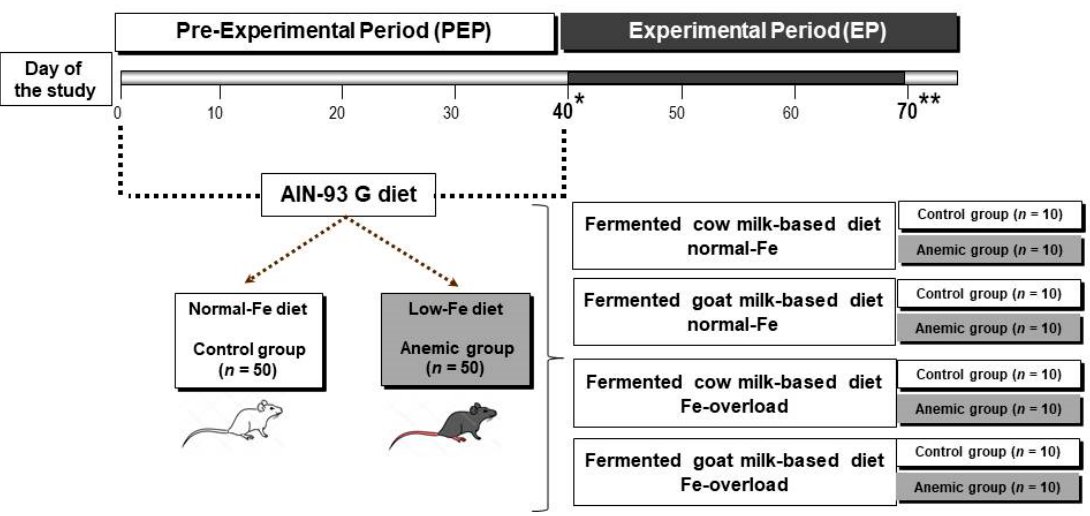
Figure 1. The study experimental design. * 10 control and 10 anemic rats were totally bled out by cannulation of the abdominal aorta. ** 80 animals were totally bled out by cannulation of the abdominal aorta. AIN-93 G diet, Standard diet from the American Institute of Nutrition (for the growth phase).